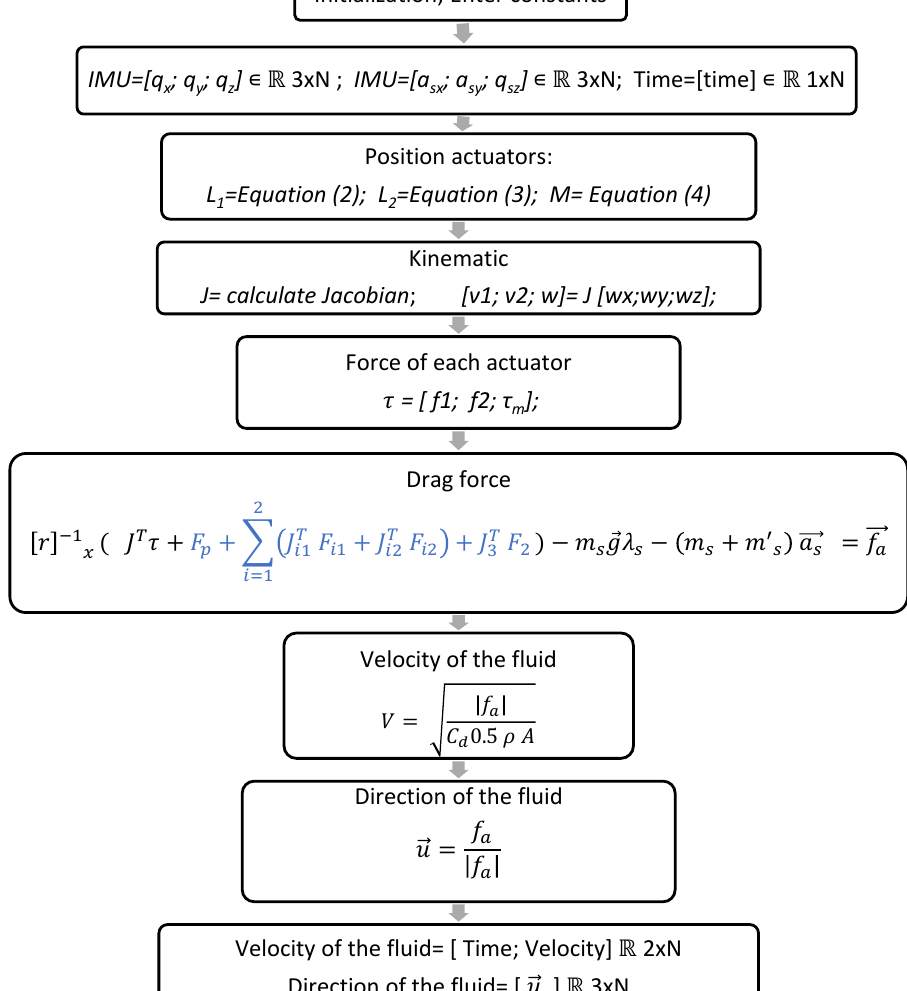
Figure 5. Algorithm for calculating the velocity and direction of the fluid with the parallel mechanism.